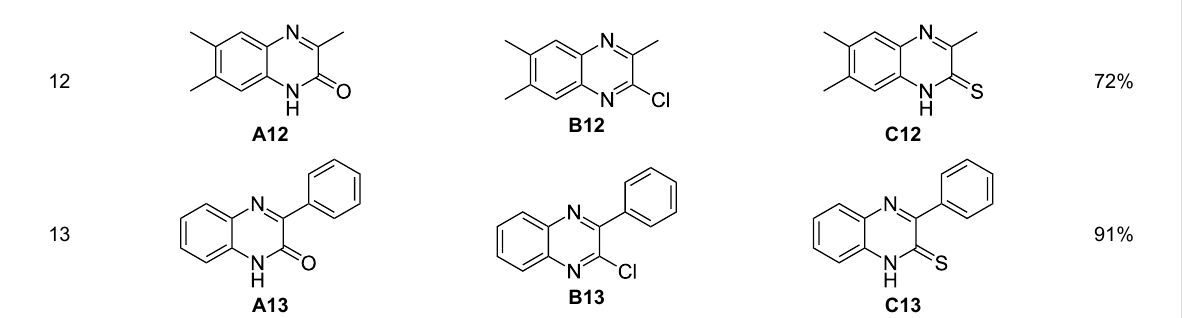
Table 3: Synthesis of quinolin-2-thiones C9 and quinoxalin-2-thiones C10–C13 a .